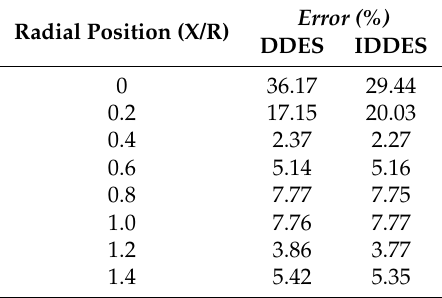
Table 4. Relative error for wake measurements 0.5 diameters behind the rotor plane, at eight different positions from 0 to 1.4 radii from root to blade